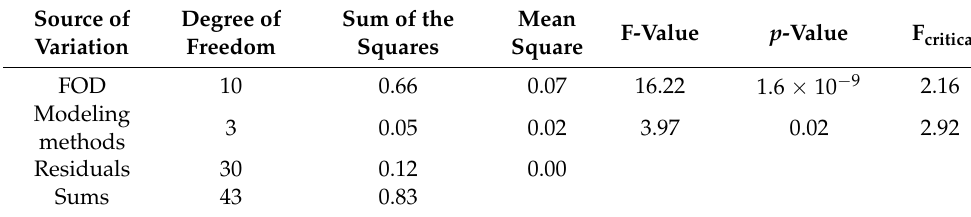
Table 9. Analyses of variance with the RMSE values for Cr.